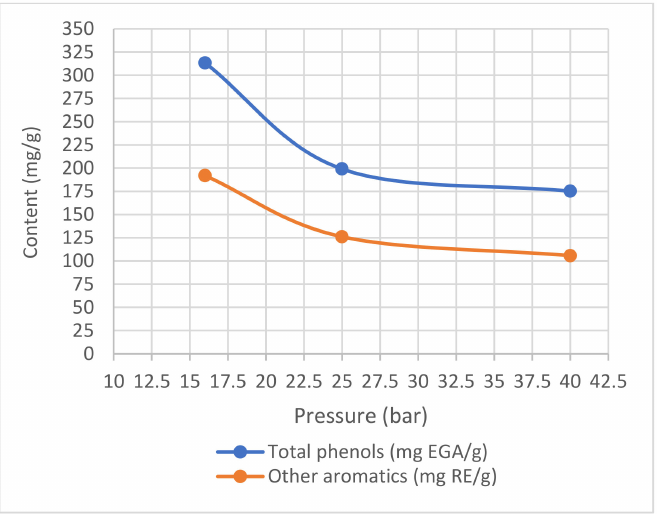
Figure 4. The influence of carbon dioxide pressure on lignin decomposition in subcritical